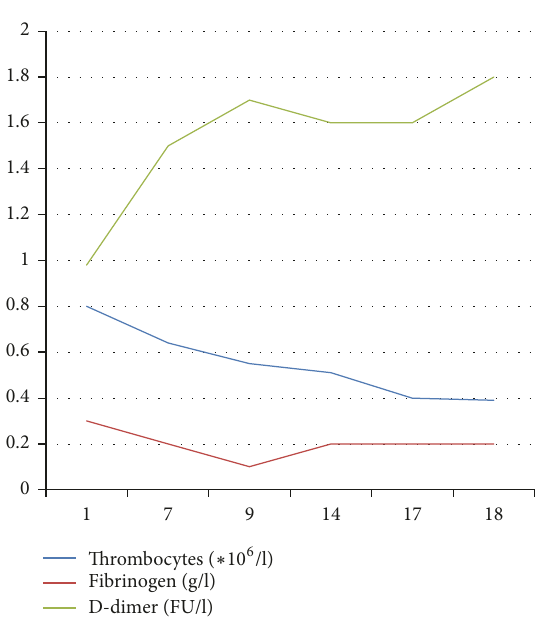
Figure 1: The course of coagulation abnormalities.